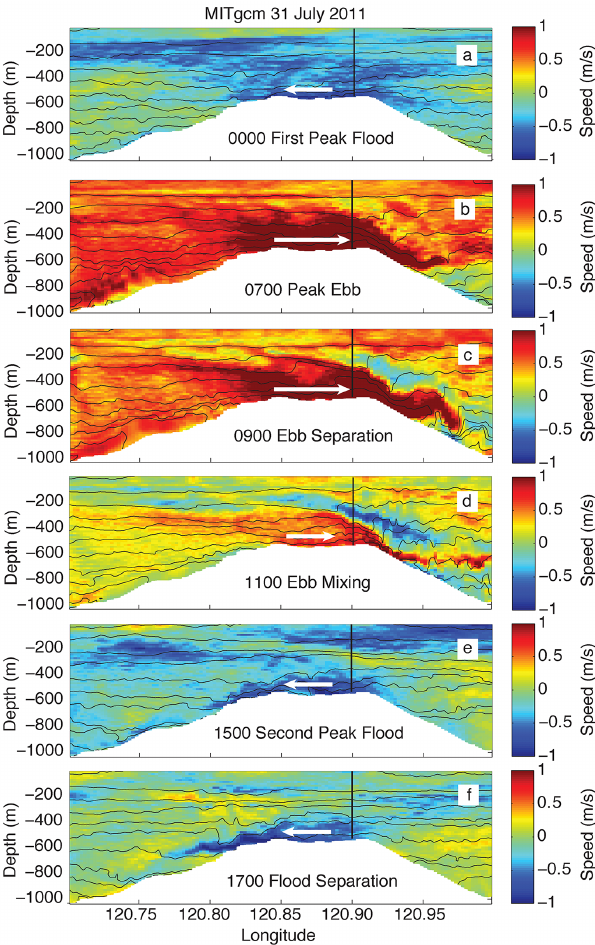
Figure 13. Selected snapshots of the u velocity component (across- ridge) along latitude 21.6 ◦ N from longitude 120.50 to 121.00 ◦ E. Sections were chosen to illustrate phenomena and the time differ- ence between sections is not constant. The velocities are output from the MITgcm model computed as described in the text. The thin gray lines are isopycnals. The vertical black line is the loca- tion of anchor station AC, where the model time series for the same day is presented in Fig. 12a. White arrows indicate the direction and relative magnitude of the tide across the top of the